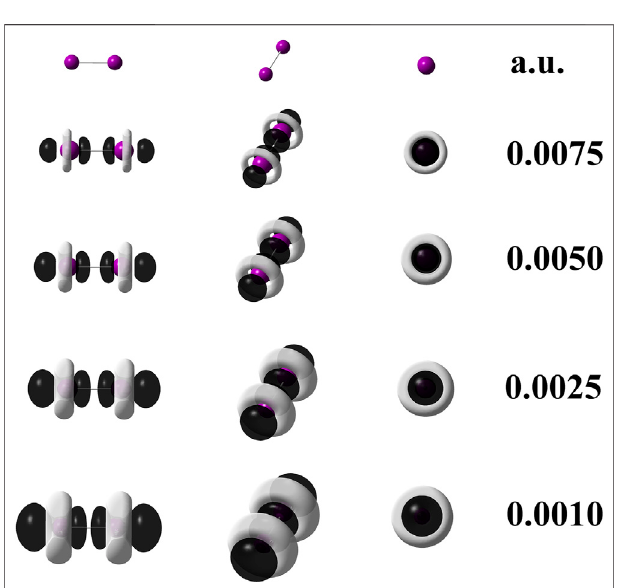
FIGURE 4 | Dual descriptor (DD) of diiodine computed at the M06 – L/ def2-QZVPPD at different isovalues given in atomic units. To use Eq. 6 , the following densities of frontier molecular orbitals were employed: | Ψ LUMO ( r )| 2 , | Ψ ( r )| 2 ,and | Ψ ( r )| 2 .Purple spheres standforiodineatoms, HOMO HOMO − 1 black – colored lobes represent positive values of DD ( f (2) ( r ) > 0); white – colored lobes correspond to negative values of DD ( f (2) ( r ) < 0).